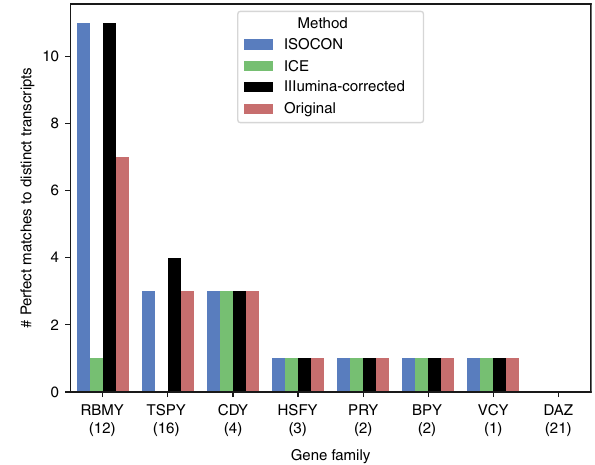
Fig. 4 Ability of the methods to capture reference protein-coding transcripts in ENSEMBL database. The numbers in parentheses next to the gene family name in the x -axis indicate the number of unique transcripts in the database. No coding sequences are present for